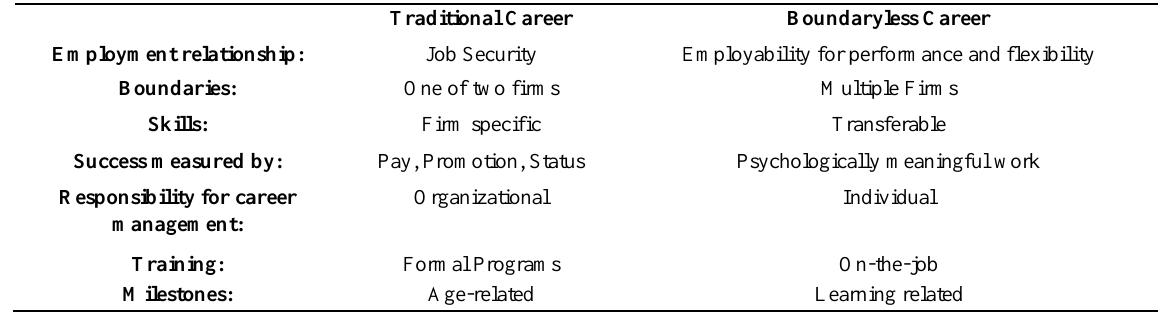
Table 2: Comparisons of Traditional Career and Boundaryless Career Traditional Career Boundaryless Career